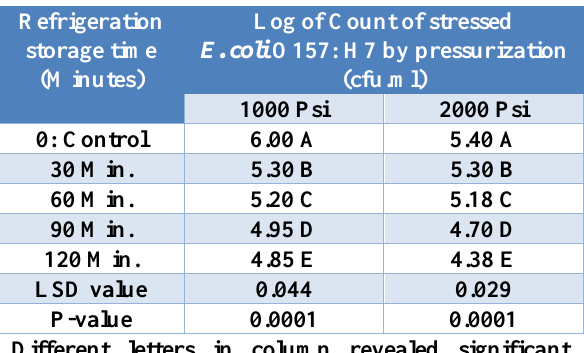
Table, 3: Effectiveness of crude bacteriocin on the viability loss of stressed E. coli O157: H7 by pressurization in nutrient broth.